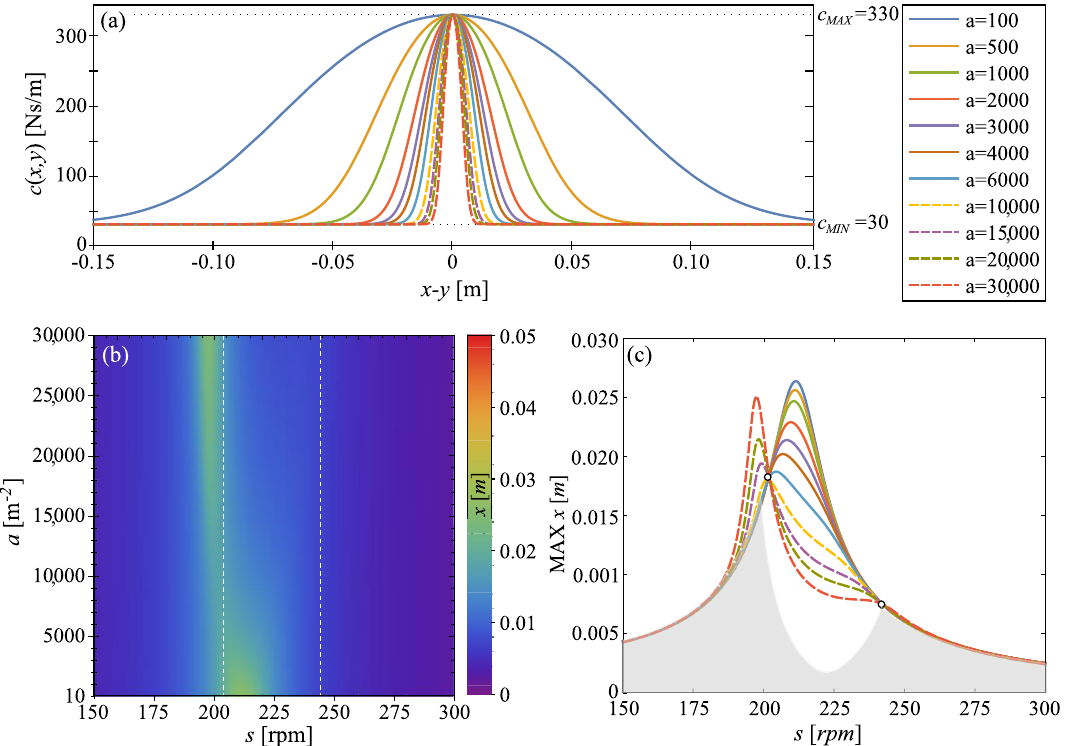
Figure 5. In panel ( a ) we show the damping functions c ( x , y ) (Equation (5)) for selected values of a . In panel ( b ) we show a two dimensional plot of maximum amplitude of damped system (max x [ m ] ) in two parameters of space: a and s . The last panel ( c ) shows eleven exemplary FRCs of damped